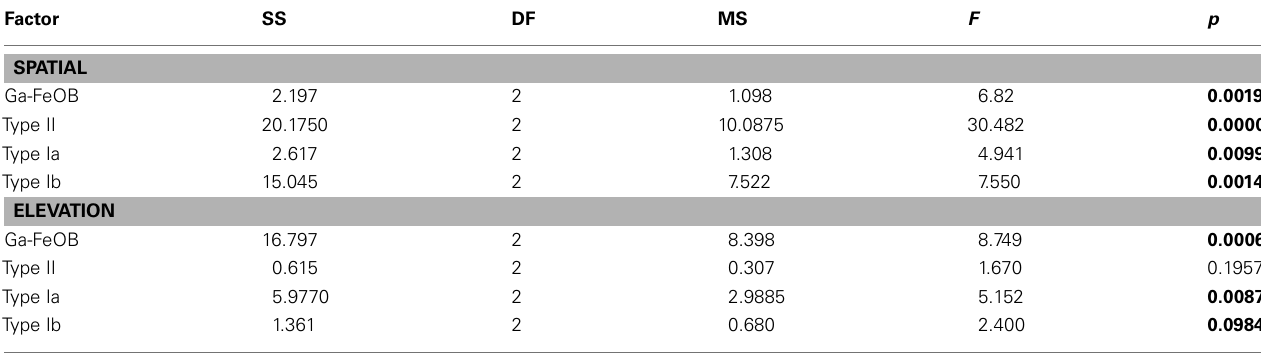
Table 1 |ANOVA analyses of effects of spatial factors and elevation on gene copy numbers of Ga-FeOB, type Ia, Ib, and II MOB. Factor SS DF MS F